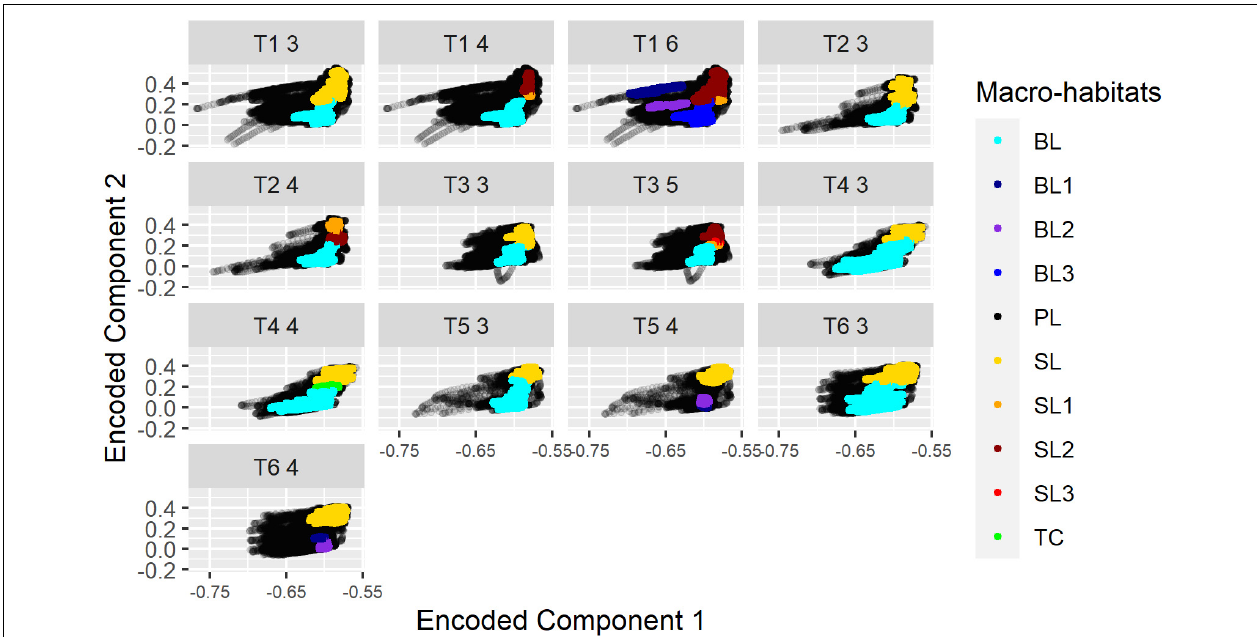
FIGURE 5 | Projections for different segregations of all transects from HE429. The number of segregated macro-habitats is indicated by the last digit in the panel header. BL, Bottom layer (blue); SL, Surface mixed layer (yellow-red); TC, Thermocline Layer; PL, Productive layer (black). Numbers were used to indicate that, e.g., more than 1 “Bottom layer” was segregated (e.g., B1/B2 instead of BL).